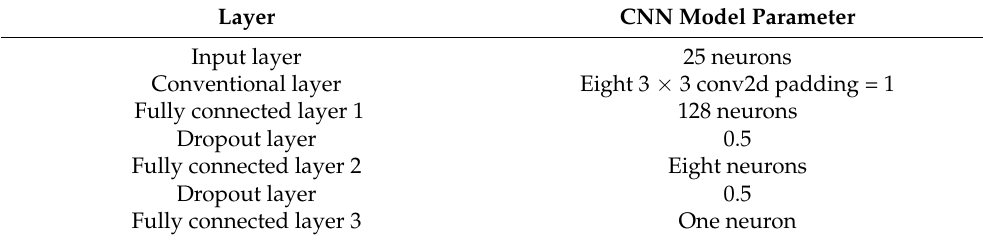
Table 3. Details of the CNN model.